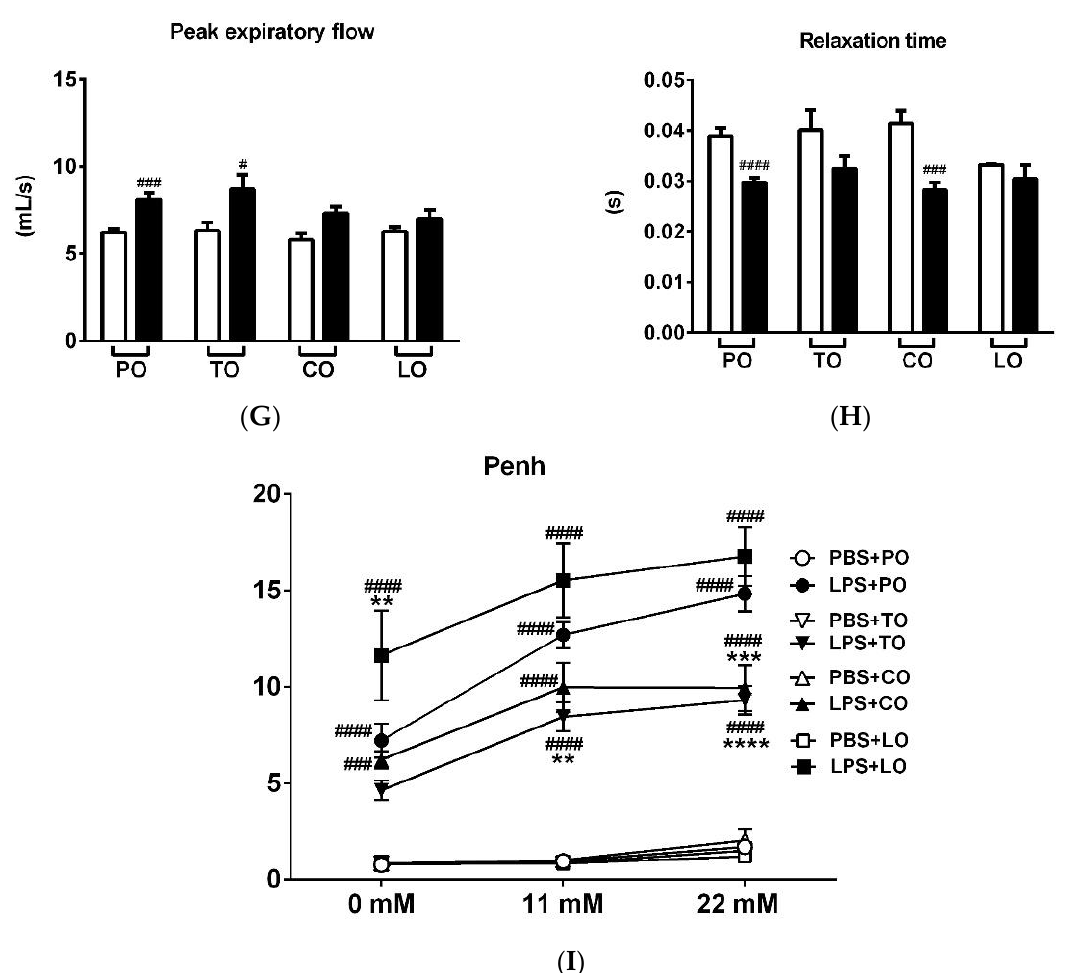
Figure 1. Effects of thyme (TO), cinnamon (CO) and lemongrass (LO) essential oils on ( A ) breathing frequency, ( B ) tidal volume, ( C ) minute ventilation, ( D ) time of inspiration, ( E ) time of expiration, ( F ) peak inspiratory flow, ( G ) peak expiratory flow, ( H ) relaxation time and ( I ) Penh compared to the negative control paraffin oil (PO), after lipopolysaccharide (LPS - black columns)/phosphate-buffered saline (PBS - white columns) treatment. ( n = 8 – 10/group, # p < 0.05, ## p < 0.005, ### p < 0.0005, #### p < 0.0001 vs. respective PBS-treated group, * p < 0.05, ** p < 0.005, *** p < 0.0005, **** p < 0.0001 vs. LPS- PO-treated mice).